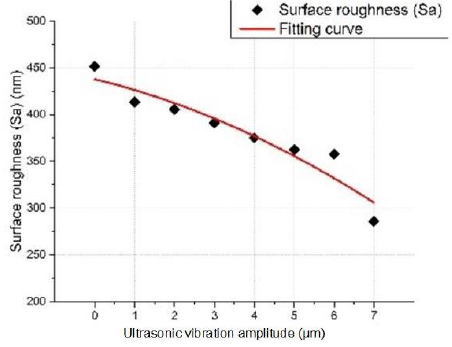
Figure 7. Influence of ultrasonic vibration amplitude on surface roughness.